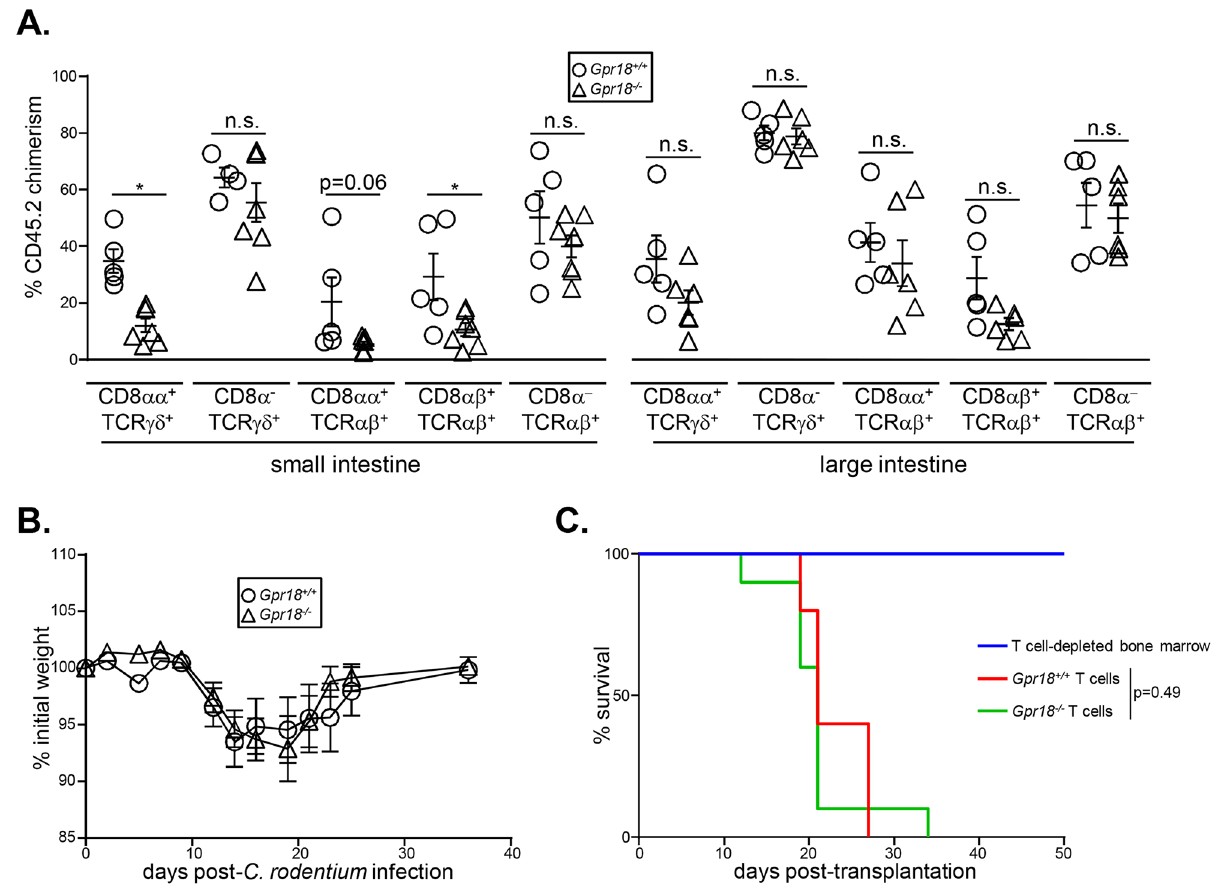
Fig 5. GPR18 is dispensable for resistance to C . rodentium infections and graft versus host disease. (A) 5 x 10 6 bone marrow cells from Gpr18 -/- or Gpr18 +/+ mice were transplanted into sublethally irradiated wild type CD45.1 recipients. Intestinal IEL chimerism was measured 8 weeks post- transplantation. Mean values ± SEM are shown. * p < 0.05 using student's 2-tailed unpaired t-test. (B) Gpr18 -/- or Gpr18 +/+ bone marrow chimeras were orally gavaged with C . rodentium . Weight after infection was quantified for 37 days. Mean values ± SEM are shown, n = 10 for each group. No statistically significant differences were observed at any timepoint by students' 2-tailed t test. (C) Lethally-irradiated (900 cGy) Balb/c mice were transplanted with 5 x 10 6 T cell-depleted bone marrow cells from a CD45.1 + C57Bl/6 mice with or without 5 x 10 5 splenic pan T cells from CD45.2 + Gpr18 +/+ or Gpr18 -/- littermates. Survival was measured over the course of 50 days. Two recipients of T cell-depleted bone marrow only, 10 recipients of Gpr18 -/- splenic pan T cells, and 5 recipients of Gpr18 +/+ splenic pan T cells were assessed. No significant differences (p = 0.49) in survival were observed using log-rank Mantel-Cox test.